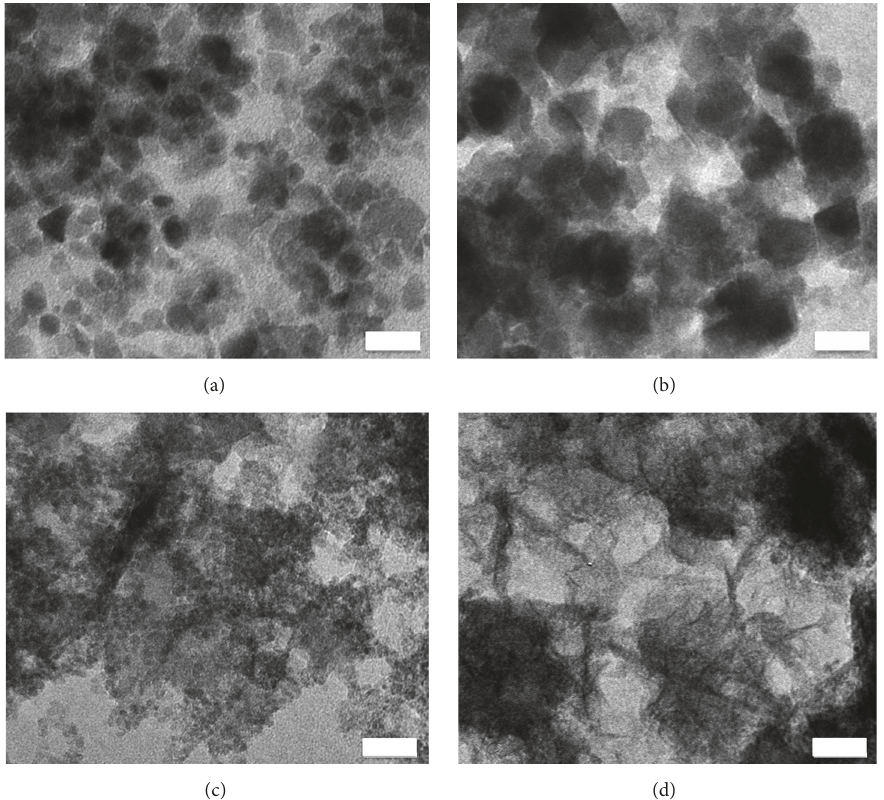
Figure 1: Morphology changes induced by the presence of Mn in the nanostructures’ formation highlighted by transmission electron microscopy. The stoichiometry ratio Fe: Mn was (a) 100: 0, (b) 88 :12, (c) 75:25, and (d) 50 :50. Scale bar = 20